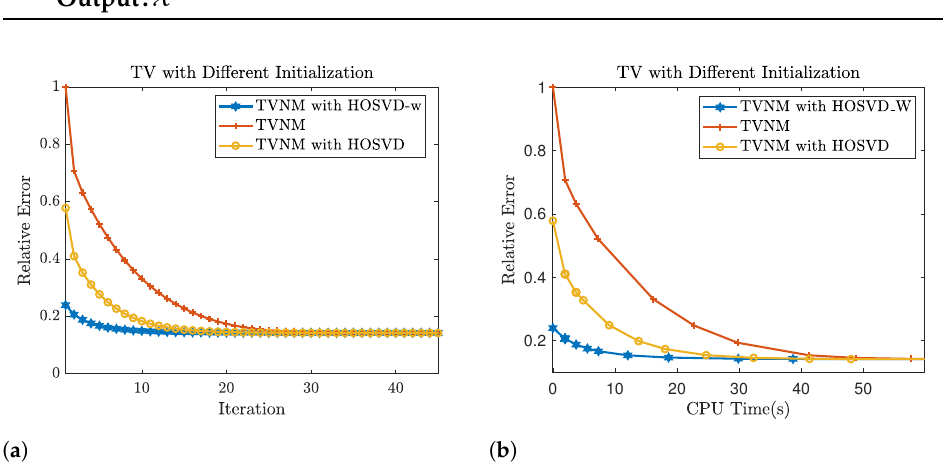
Figure 8. Convergence comparison between total variation minimization (TVM) with HOSVD-w, 0 , and HOSVD as initialization on video 1 with SR = 50%: ( a ) the relative error (cid:107) (cid:98) T −T (cid:107) F iterations. ( b ) the relative error v.s. total computational CPU time(initialization +